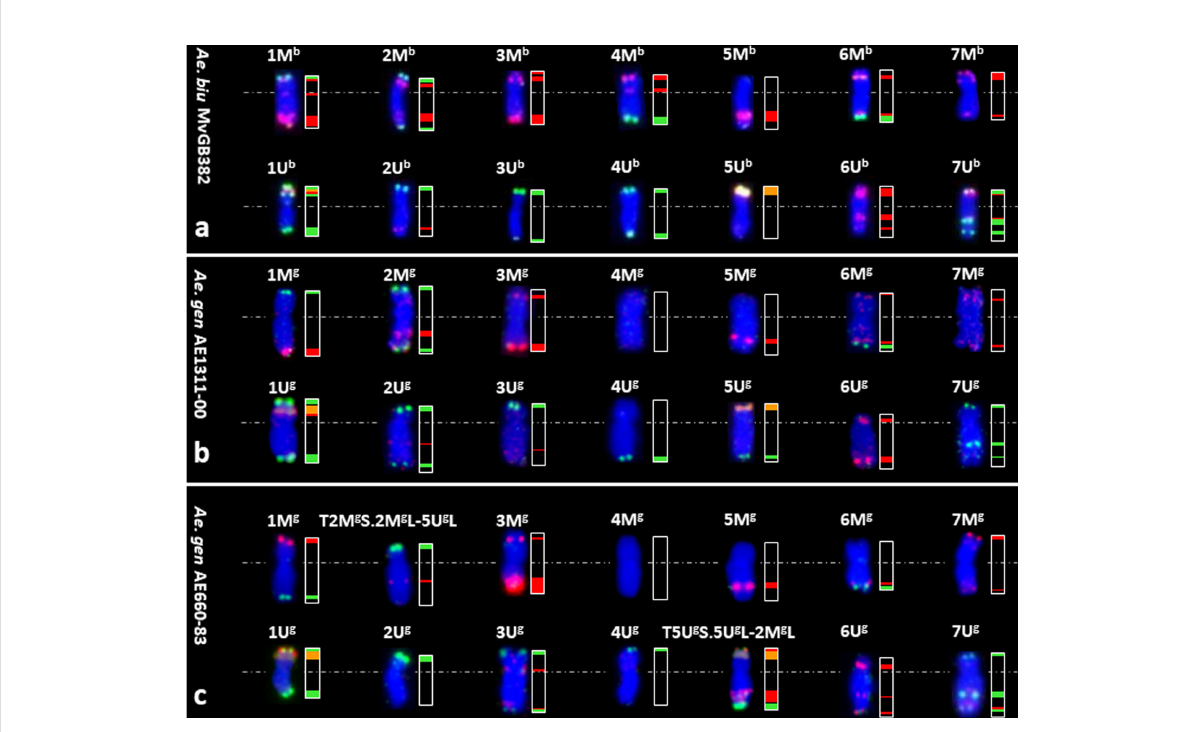
FIGURE 2 Identi fi cation of the M- and U-genome chromosomes (left) fl ow sorted from Aegilops species and their Idiograms (right). FISH with probes for Afa family repeat (red), 45S rDNA (orange) and pSc 119.2 repeat (green) on chromosomes fl ow sorted from Ae. biuncialis acc. MvGB382 (A) , Ae. geniculata acc. AE1311/00 (B) and Ae. geniculata acc. AE660/83 (C) . Chromosomes were counterstained with DAPI